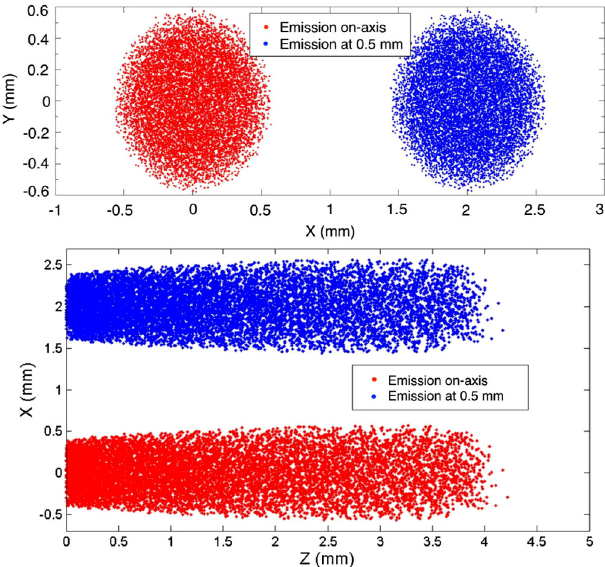
FIG. 3. Particle distribution at the cathode. Red dots are particles emitted on-axis near the center of the cathode. Blue dots are particles emitted off-axis with 2.0 mm horizontal misalignment. (Upper) X-Y projection. (Lower) Z-X projection.